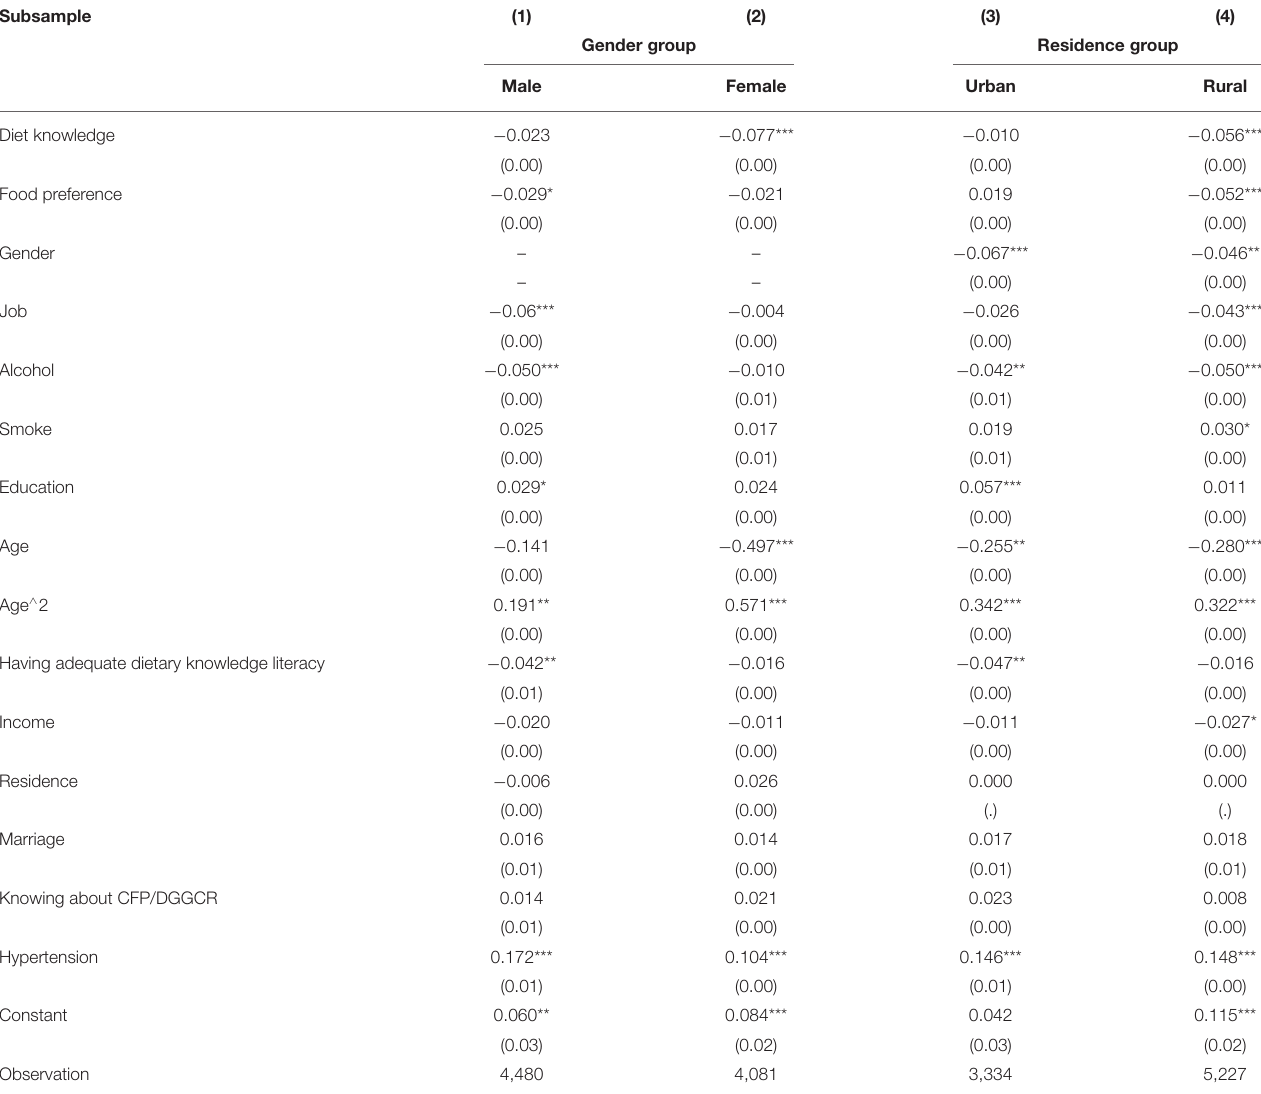
TABLE 5 | OLS estimates-effect of diet score on stroke by gender group & residence group.